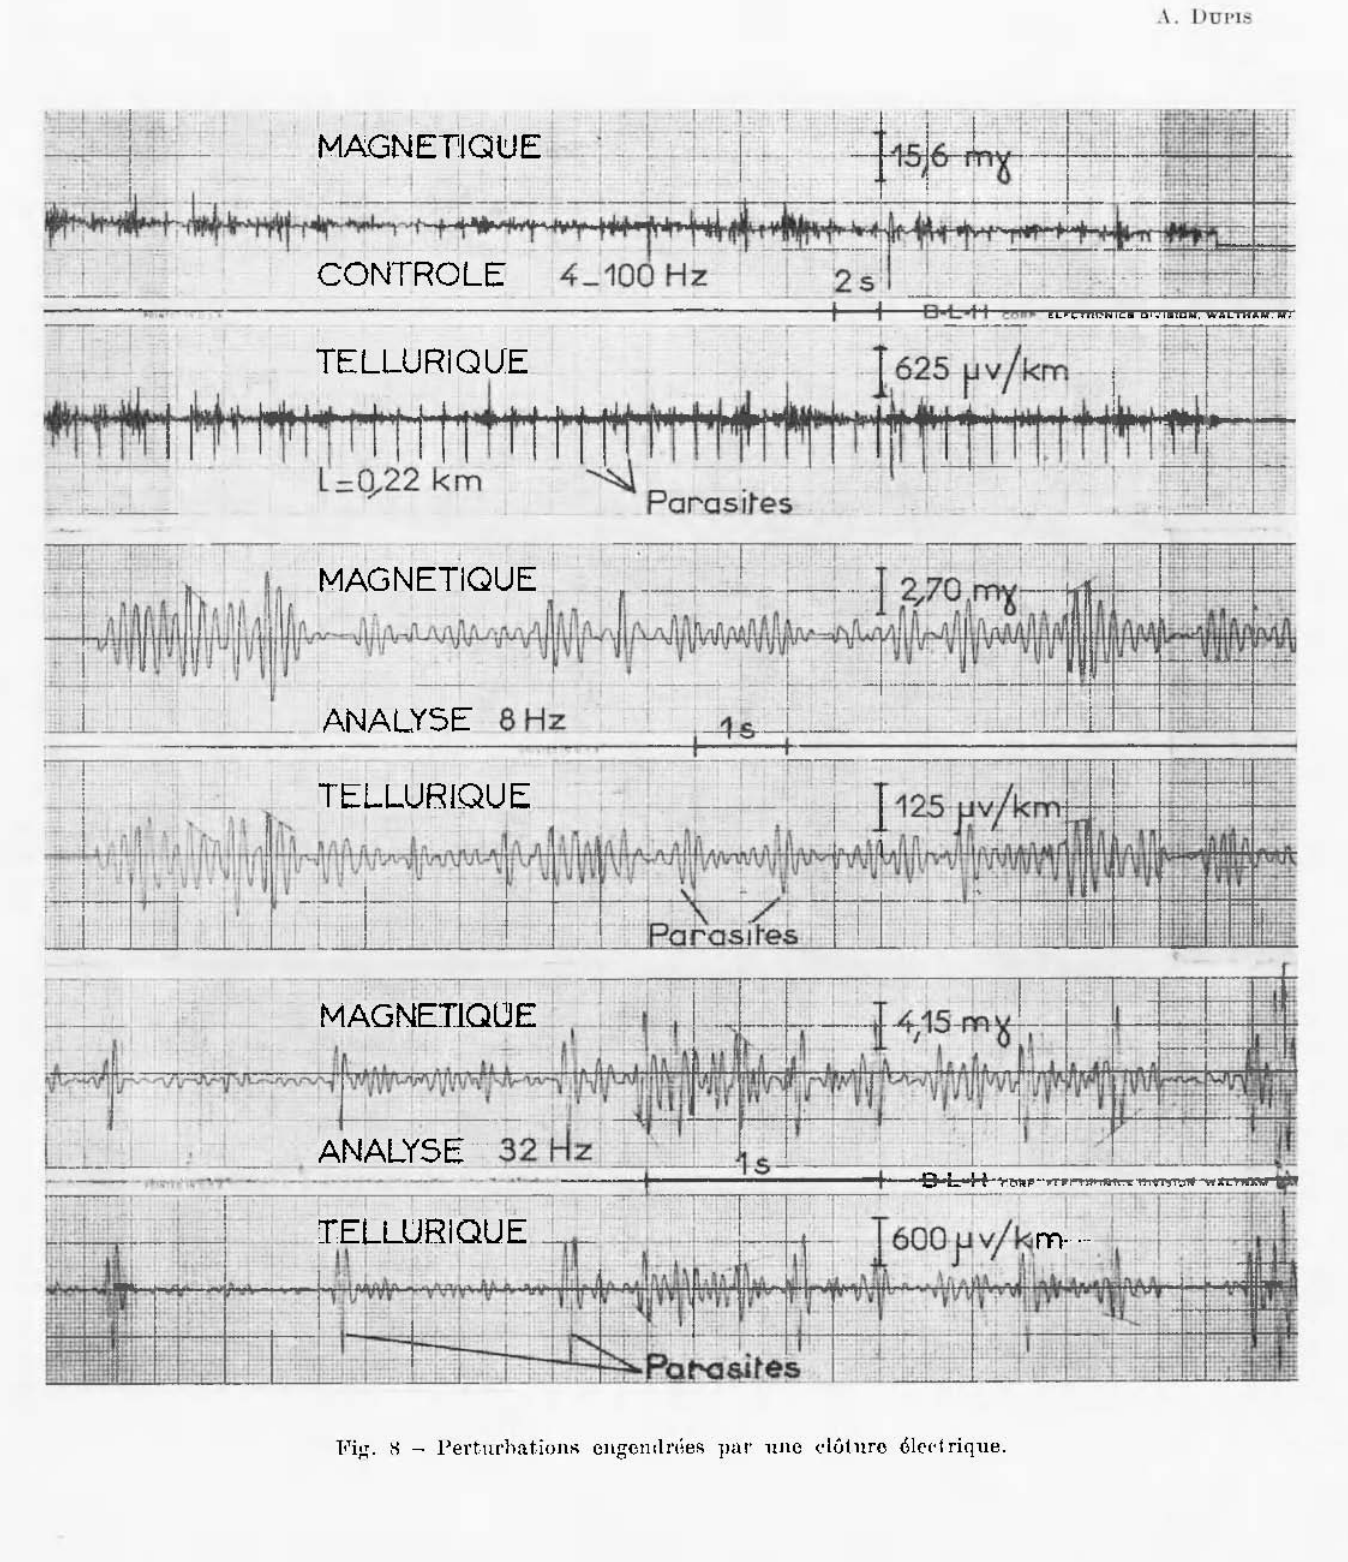
Fig. K _ l'ert\lrhation" ellgellllr(leR ]la!" une dUture